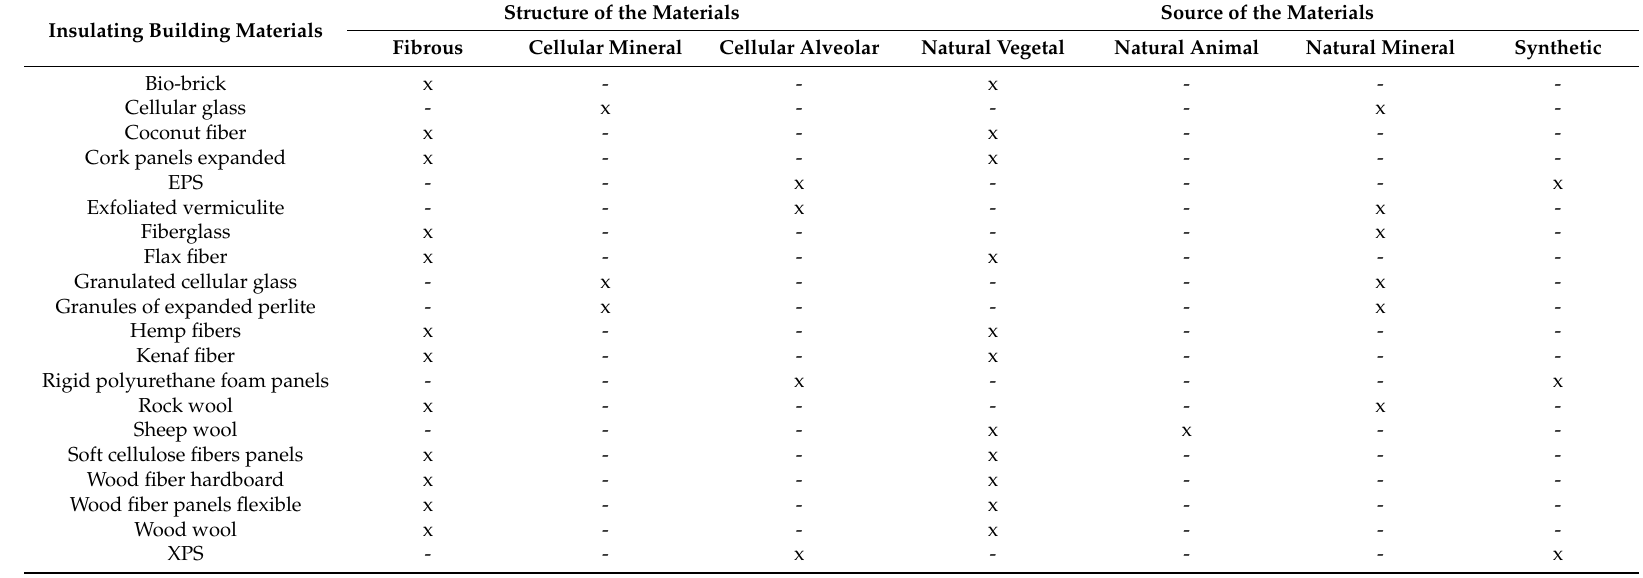
Table 4. Source and structural classification of insulating